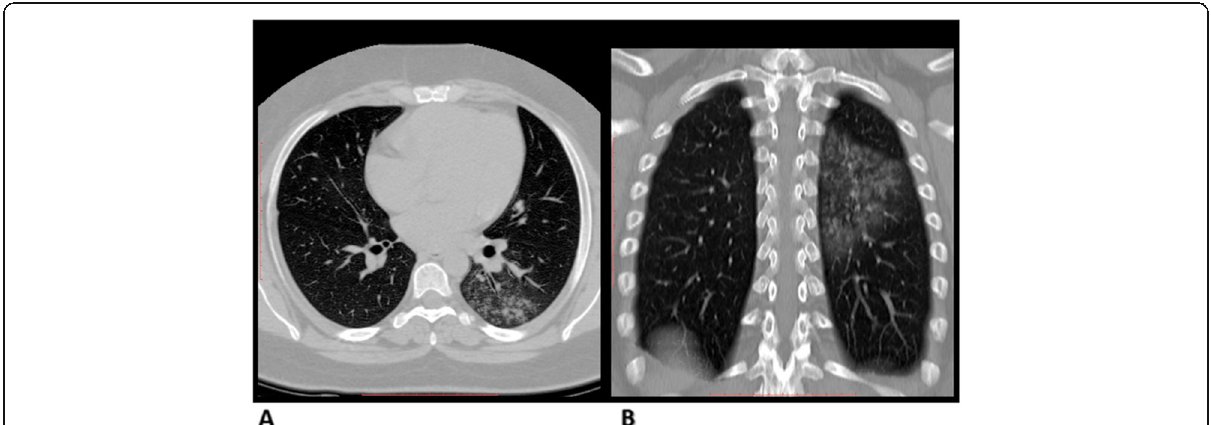
Fig. 4 A 23-year-old woman with CT findings of consolidation in the left lower lung lobe with the tree on bud appearance Observers agreed on COVID-RADS score 1 and CO-RADS score 2. The preference of COVID-RADS: CO-RADS was (1:2). RT-PCR result was